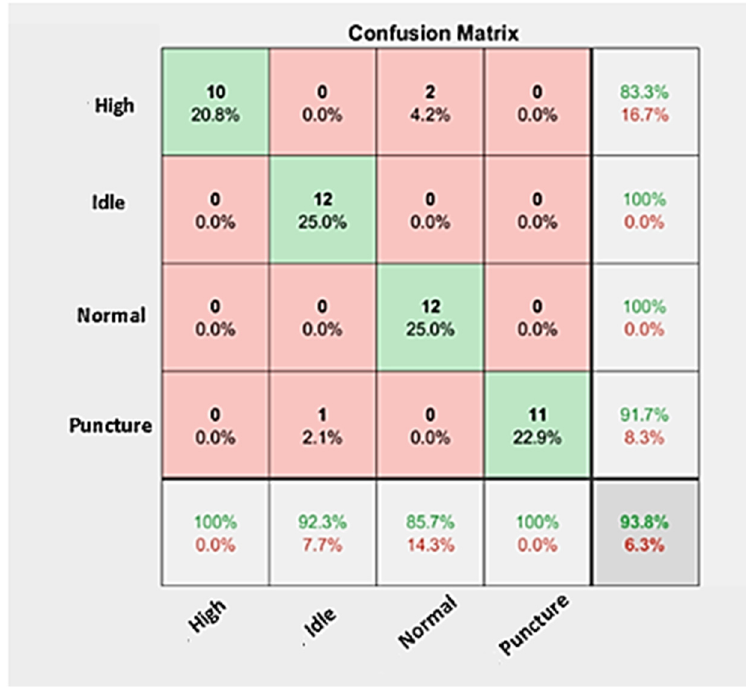
Figure 7. Confusion matrix of the ResNet-50 network.